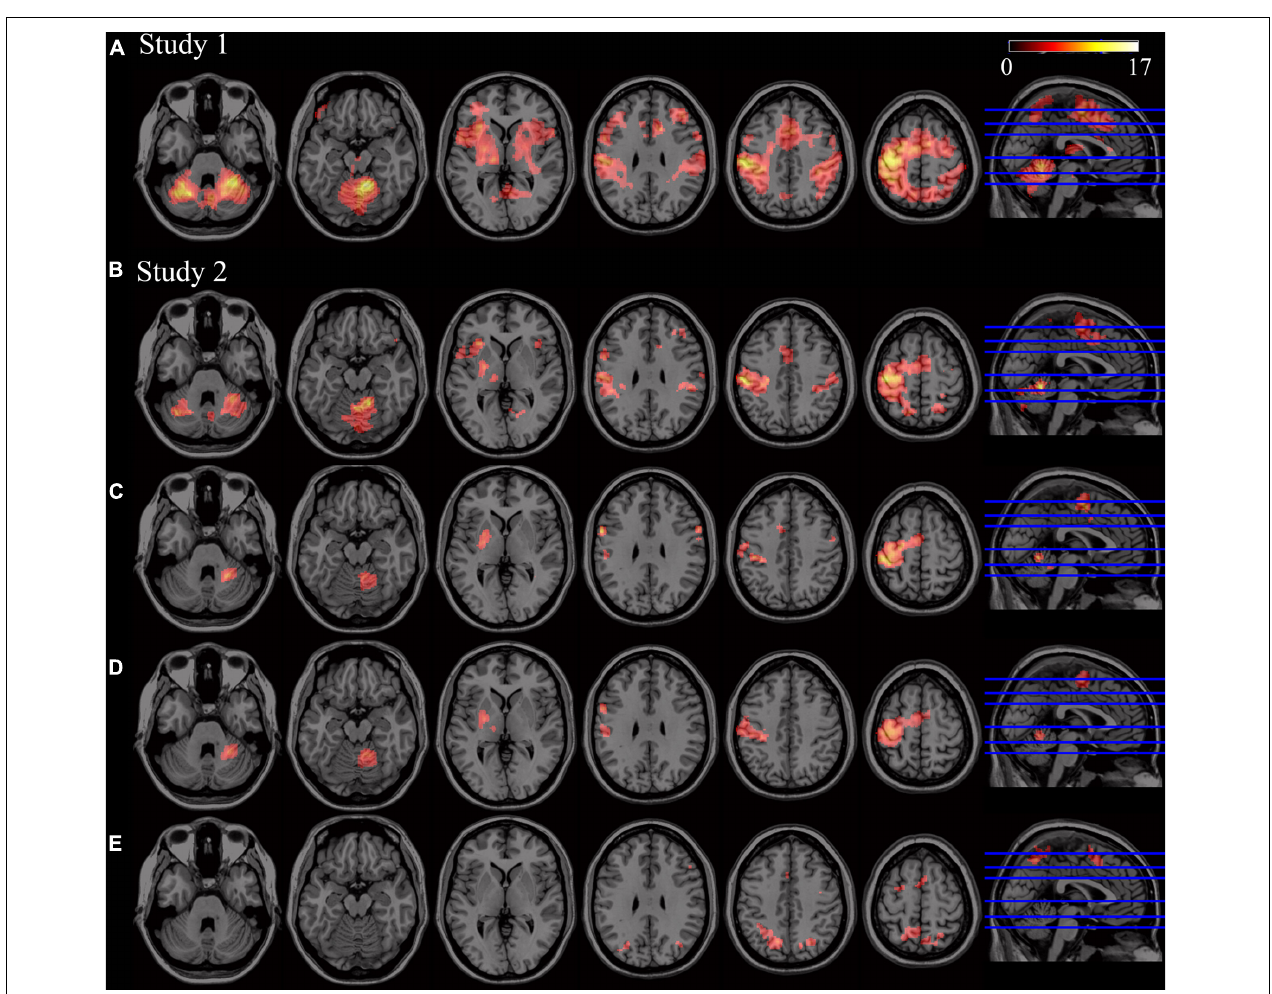
FIGURE 2 | Patterns of activity related to motor learning ( p < 0.05, FWE corrected at cluster-level -voxel defining threshold p = 0.001). (A) Significant activity during FL (second level analysis using Novel > Rest contrasts, using sample from Study 1, n = 25). (B) Significant activity during FL (second level analysis using Novel > Rest contrasts, using sample from Study 2, n = 11). (C) Significant activity during SL (second level analysis using Novel_SL > Rest contrasts). (D) Brain regions showing significant activity in both FL and SL phases (conjunction analysis of the Novel_FL > Rest_FL and Novel_SL > Rest_SL contrasts). (E) Brain regions showing significant increases in activity in FL with respect to SL phase (i.e., significant clusters resulting from second-level paired t -test analysis). No significant increases in activity were found in SL when compared to